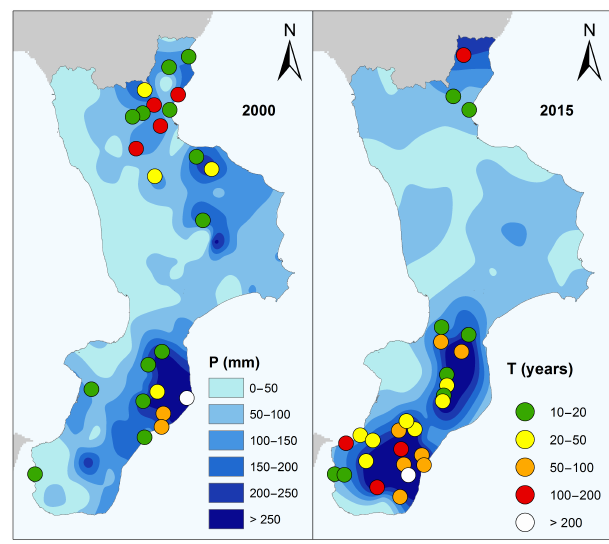
Figure 3. Maximum return period ( T ) of daily rainfall recorded during each event at the gauges (circles coloured according to the legend) and maximum values of daily rain (shades of blue, accord- ing to the